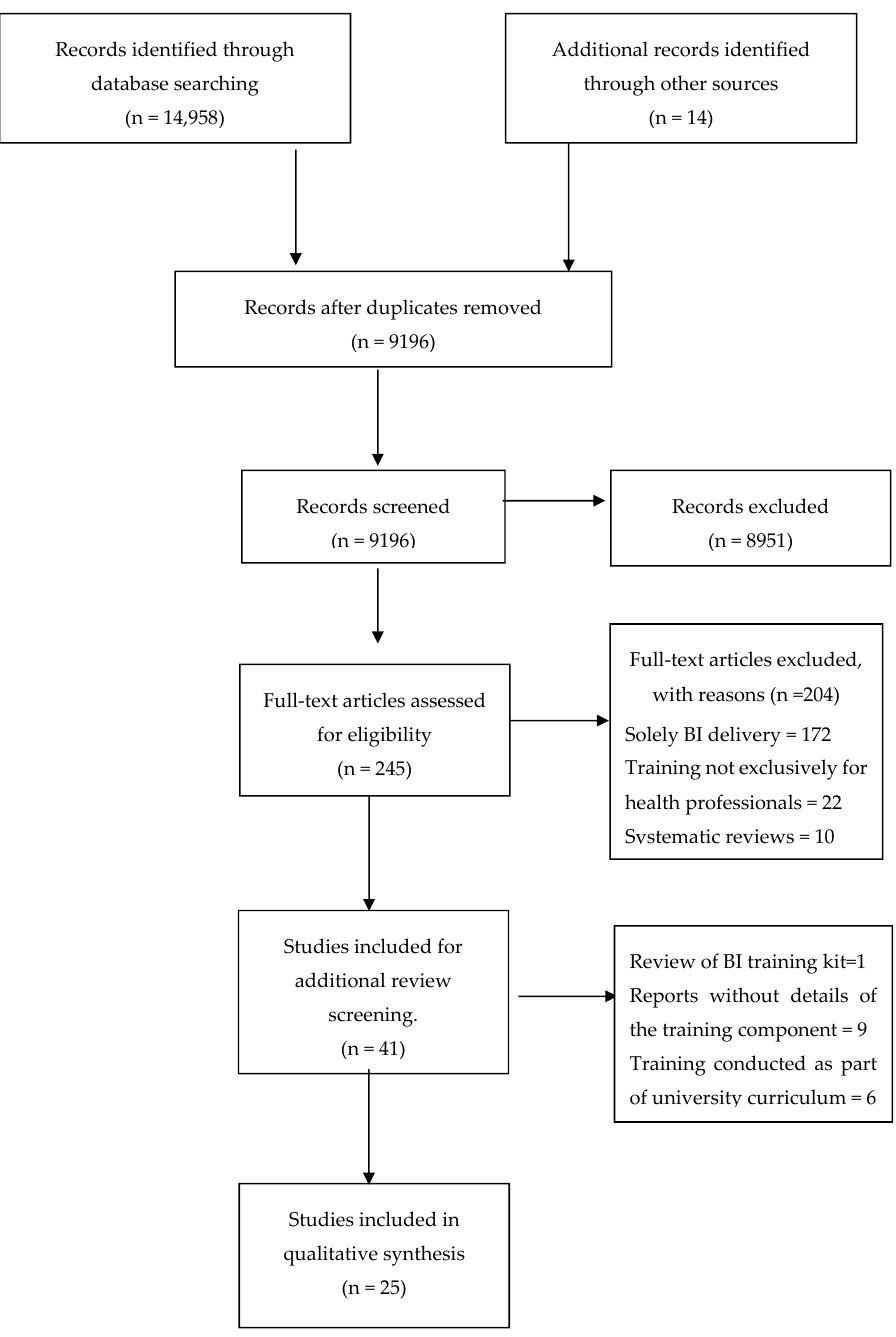
Figure 1. PRISMA flow chart (Inclusion & exclusion